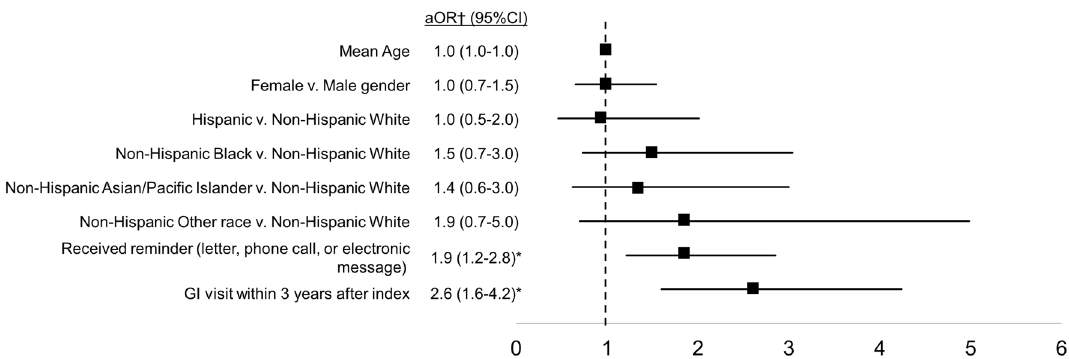
Figure 3. Predictors of surveillance colonoscopy completion at 3.5 years; n = 405. †For the multivariable model, we included age, gender, race/ethnicity, and variables significant at the P < 0.05 level in univariate analyses. Ordering provider was only relevant for patients who had a colonoscopy order and was therefore excluded. *Denotes statistical significance at the P < 0.05 level. aOR adjusted odds ratio; CI confidence interval; GI